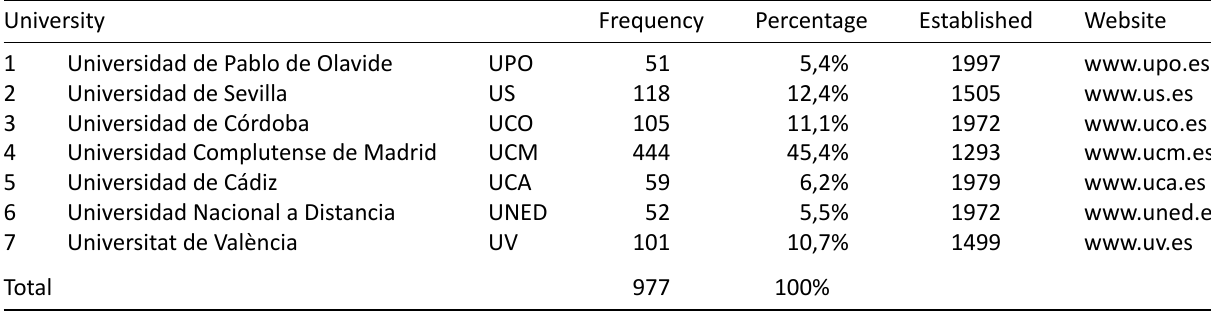
Table 1. Participating